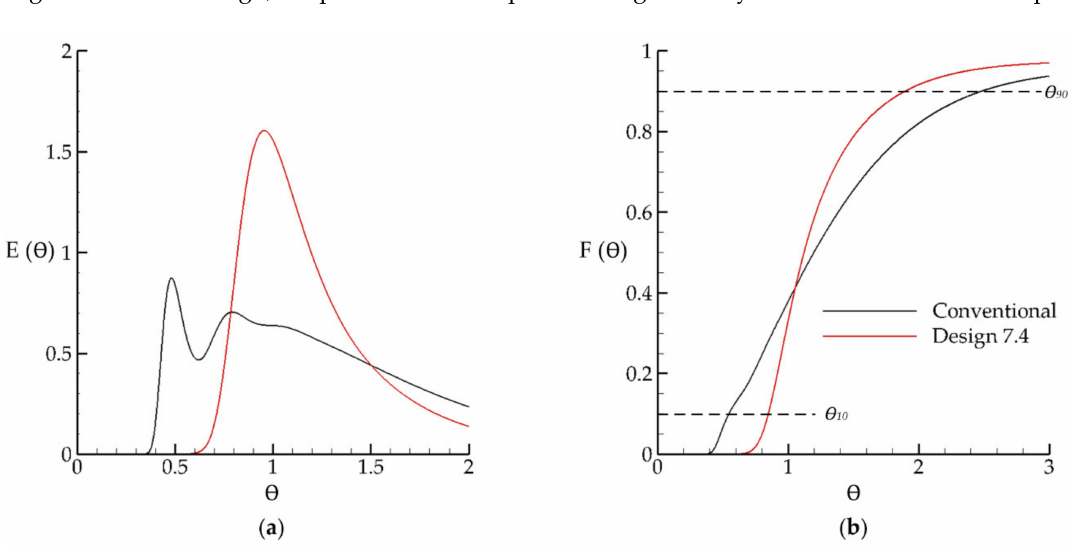
Figure 10. Comparison of tracer results for the conventional and optimized designs: ( a ) RTD; ( b )